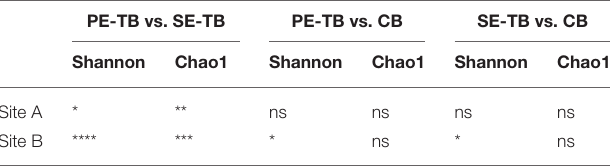
TABLE 4 | The Wilcoxon test values for comparative intra-site analysis. PE-TB vs. SE-TB PE-TB vs. CB SE-TB vs.